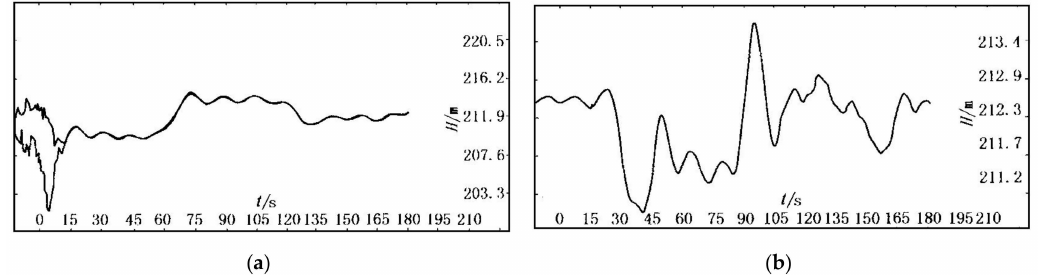
Figure 2. Experimental results for the hydraulic characteristics of unsteady flow in an SCTT. ( a ) Pressure fluctuation process at the inlet of the draft tube. ( b ) Water level fluctuation process in the free surface flow section